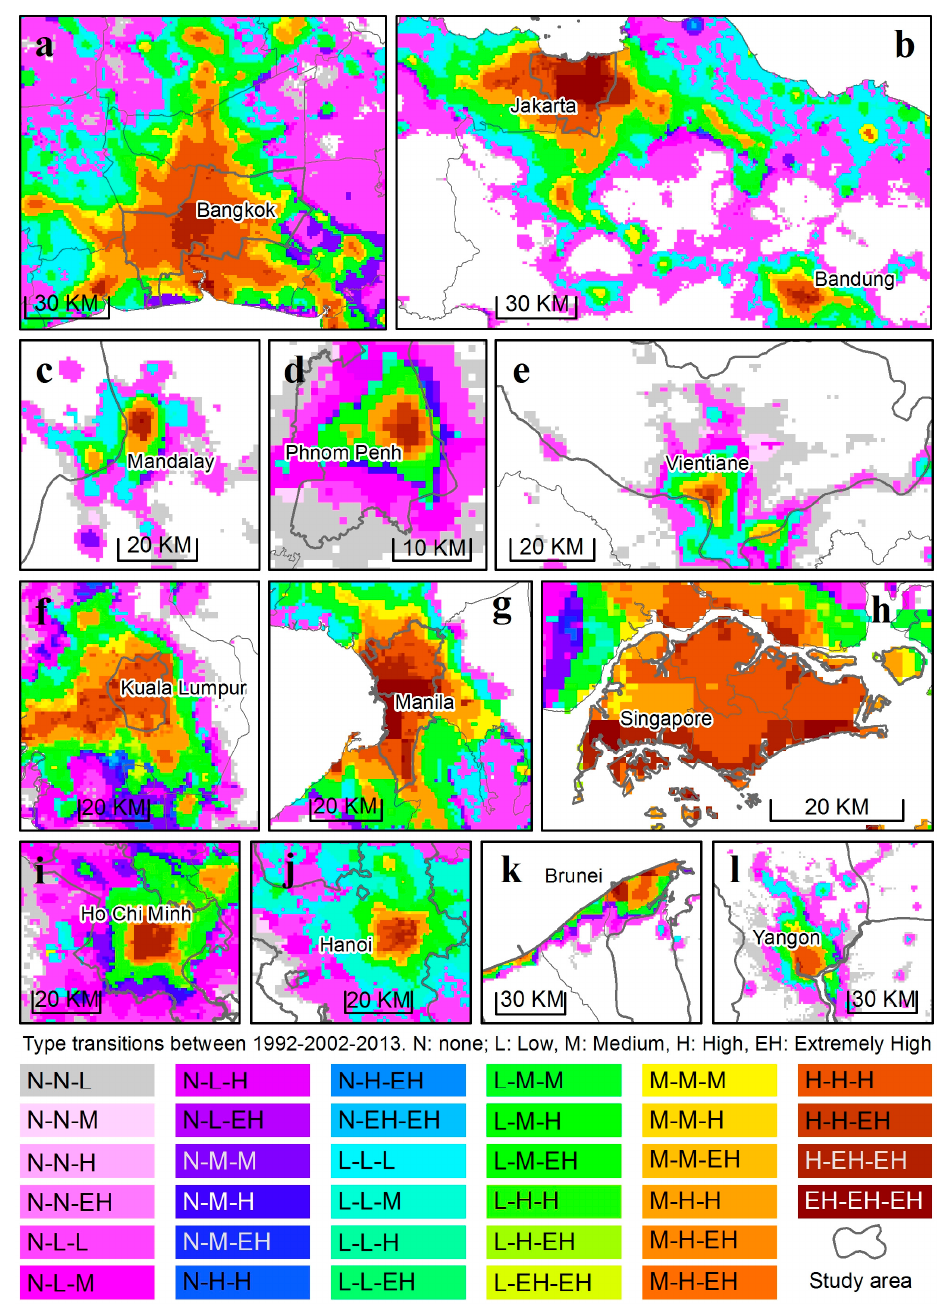
Figure 8. Spatial transitions of nighttime lighting types between the year of 1992, 2002, and 2013 in several cities and countries: ( a ) Bangkok; ( b ) Jakarta; ( c ) Mandalay; ( d ) Phnom Penh; ( e ) Vientiane; ( f ) Kuala Lumpur; ( g ) Manila; ( h ) Singapore; ( i ) Ho Chi Minh; ( j ) Hanoi; ( k ) Brunei; and, ( l ) Yangon.